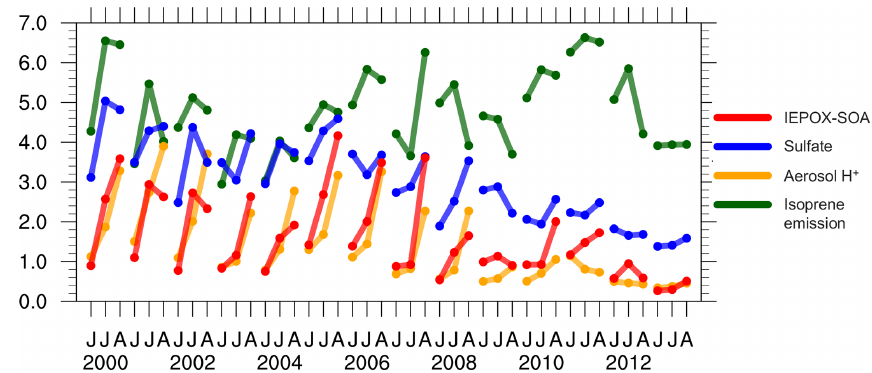
Figure 3. Standardized monthly surface IEPOX-SOA concentration, sulfate concentration, aerosol H + activity and isoprene emission from the default model. All variables are averaged over the southeast US, have been divided by 1 SDs and therefore are